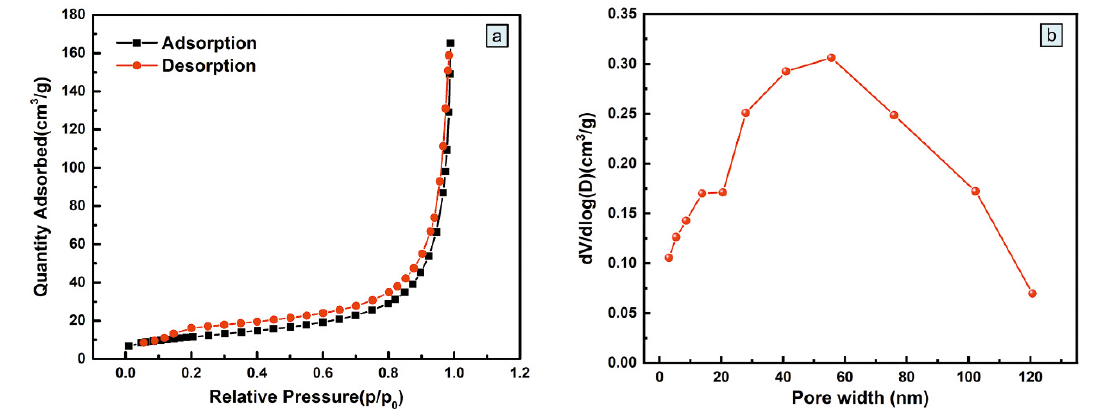
Figure 8. ( a ) N 2 adsorption / desorption isotherms for the CuS / C-120 electrode material; ( b ) Pore size distribution of the CuS / C-120 electrode material.